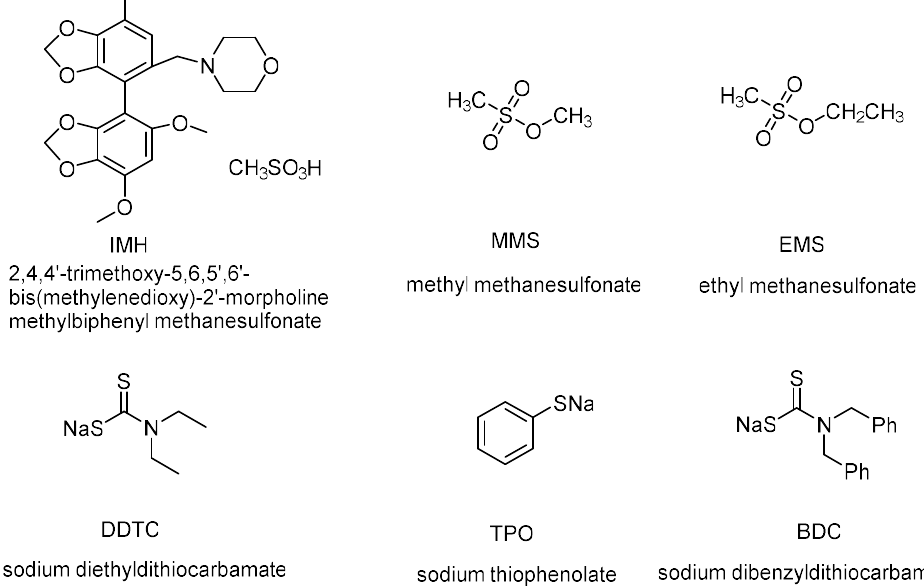
Figure 1. Chemical structures of IMH, MMS, EMS, and the derivatization reagents.